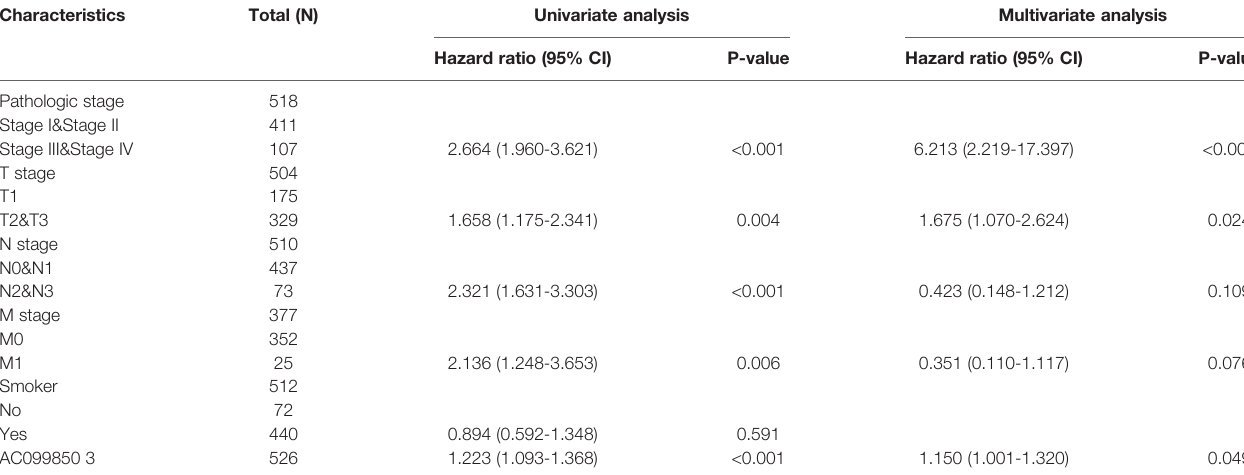
TABLE 3 | Univariate and multivariate Cox regression analyses of different parameters on OS.